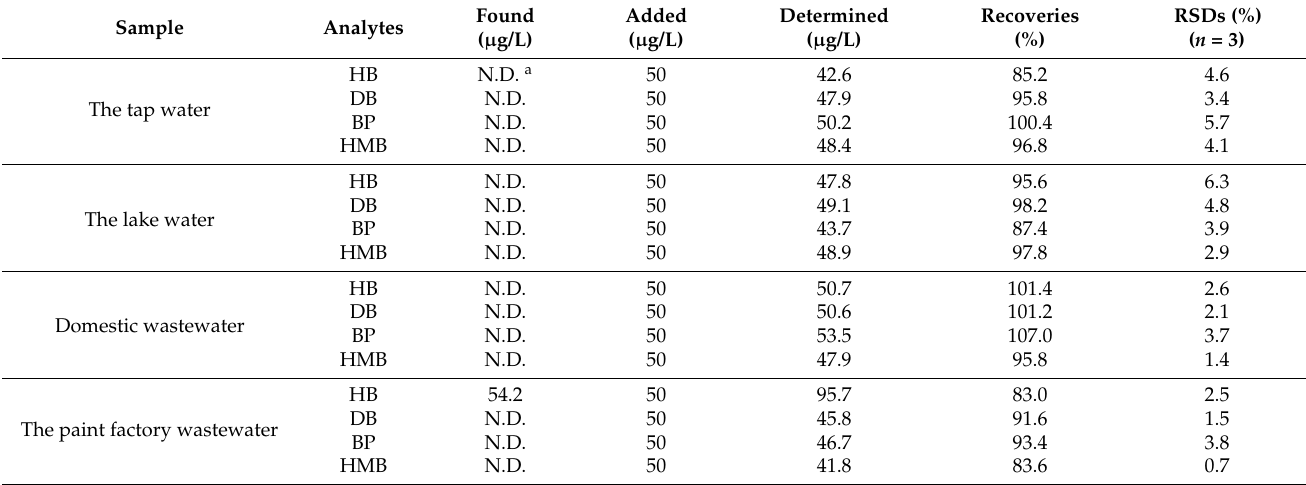
Table 3. Analytical results of environmental water